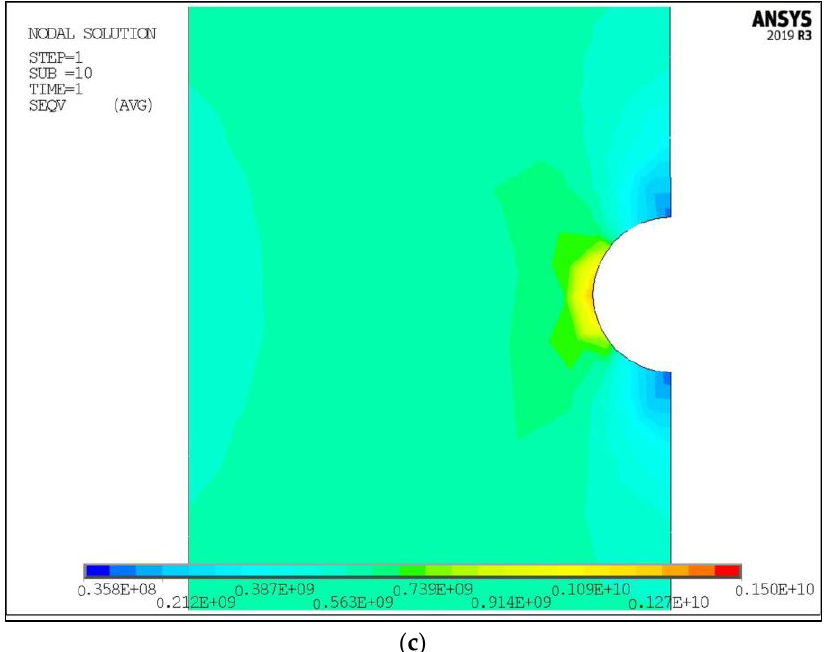
Figure 12. Detail of the cross-section plot of Von-Mises equivalent stresses for a wire with semi- spherical corrosion pits with different radii: ( a ) 0.3 mm; ( b ) 0.6 mm; ( c ) 0.8 mm.